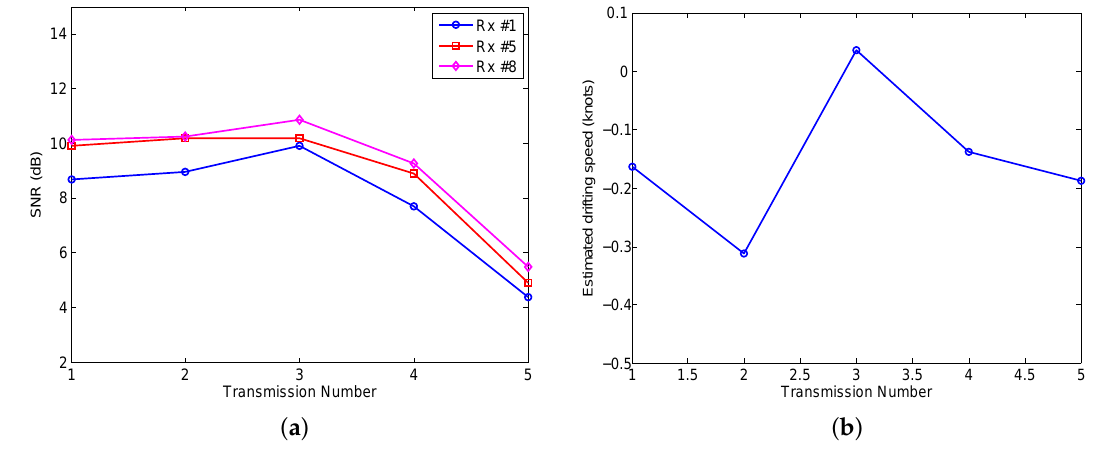
Figure 6. Estimated input SNRs ( a ), and drifting speed ( b ).